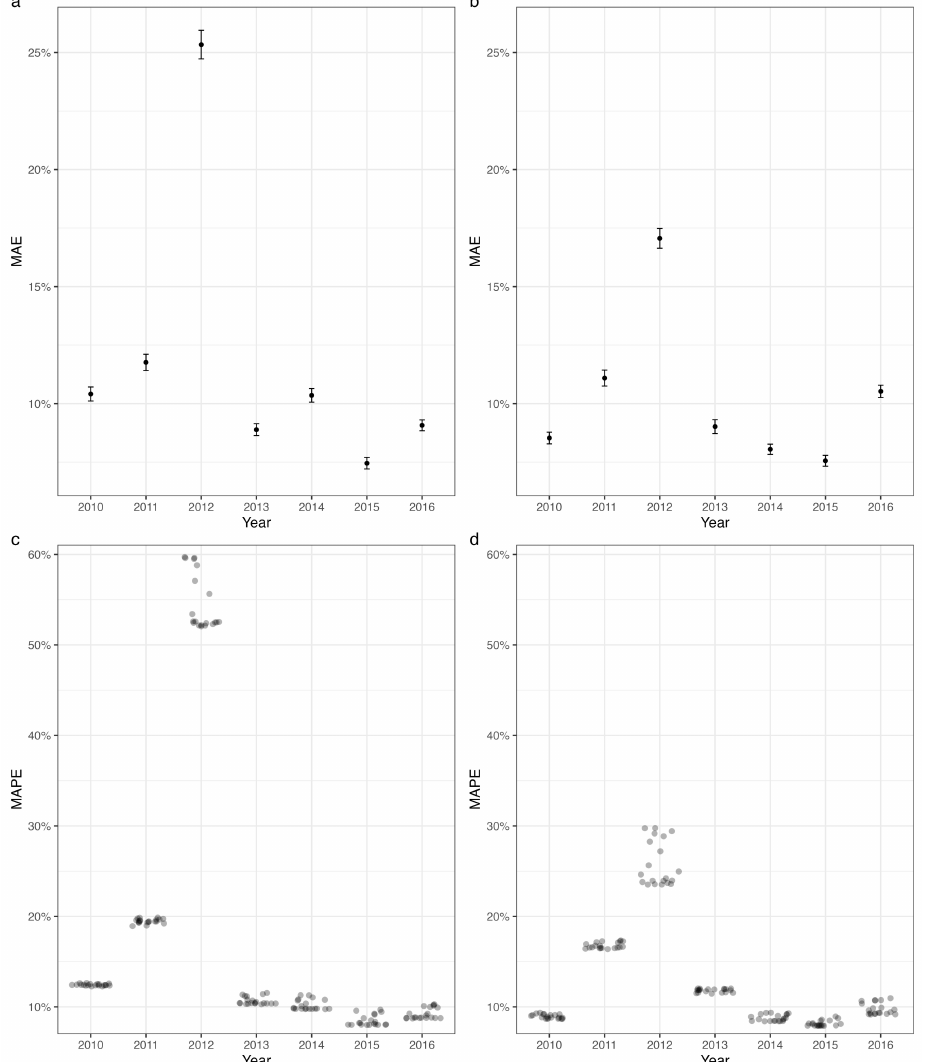
Figure 3. The errors of the relative residuals and crop yield predicted for ( a , c ) corn and ( b , d ) soybean during the period from 2010–2016. The Mean Absolute Error (MAE) was determined for the relative residuals of ( a ) corn and ( b ) soybean yield calculated using the LAI time series from the day of year (DOY) of 89 to 209. The point and error bar represent the regional average and the standard error of the relative residuals, respectively. The Mean Absolute Percentage Error (MAPE) was determined for crop yield of ( c ) corn and ( d ) soybean for the period from 2010–2016 using the time series of LAI data. The first date of the given time series was set to be DOY of 89. The last date of the time series ranged from DOY of 153 to 305, which created a series of time series data. The dot indicates the MAPE value obtained from each LAI time